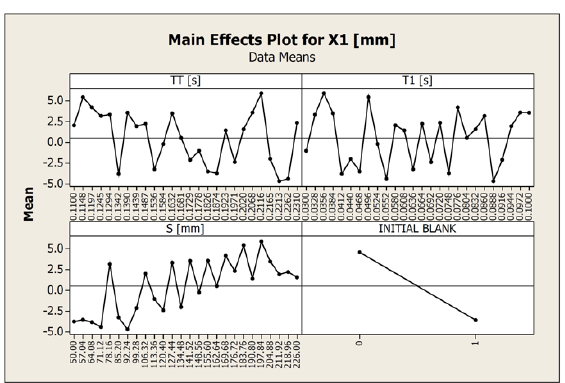
Figure 20. MEP for X1 output.